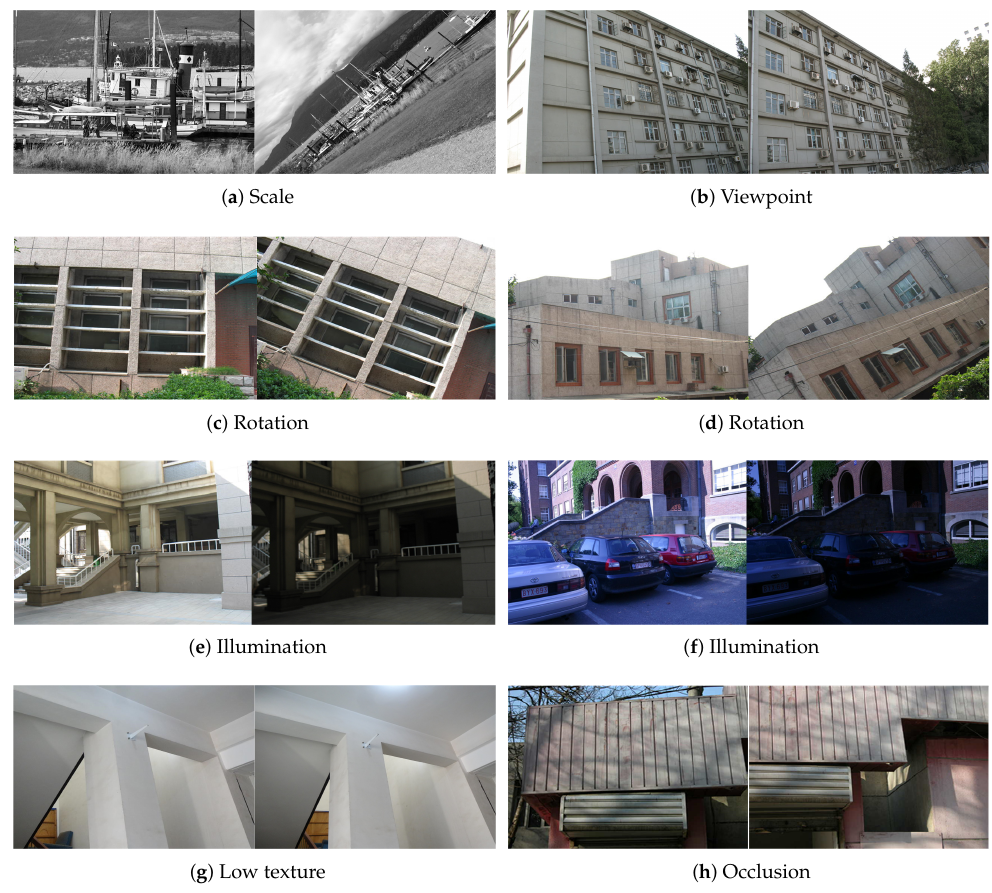
Figure 8. The datasets used in this experiment where ( a ) is the scale changes image pair, ( b ) is the Viewpoint change image pair, ( c , d ) are the rotation changes image pairs, ( e , f ) are the lighting change image pairs, ( g ) is the low-texture scene image pair, ( h ) is the occlusion image